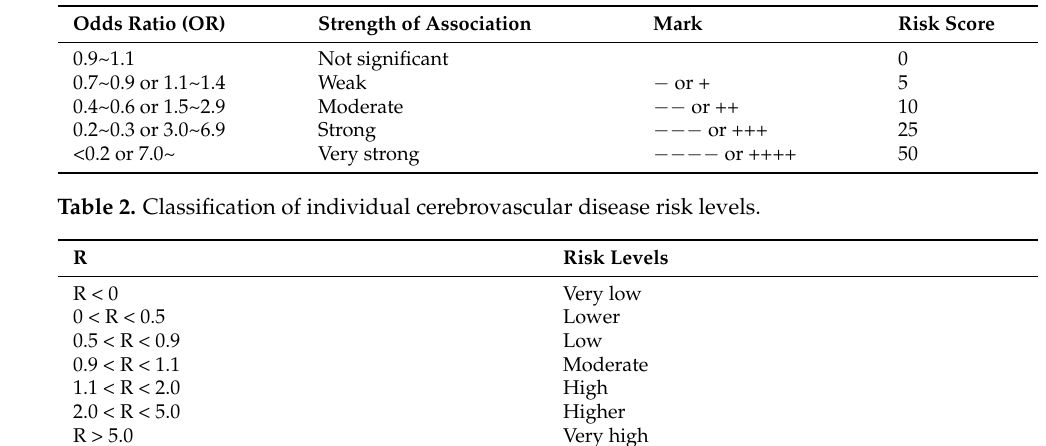
Table 1. Conversion standard of the cerebrovascular disease risk score. Odds Ratio (OR)